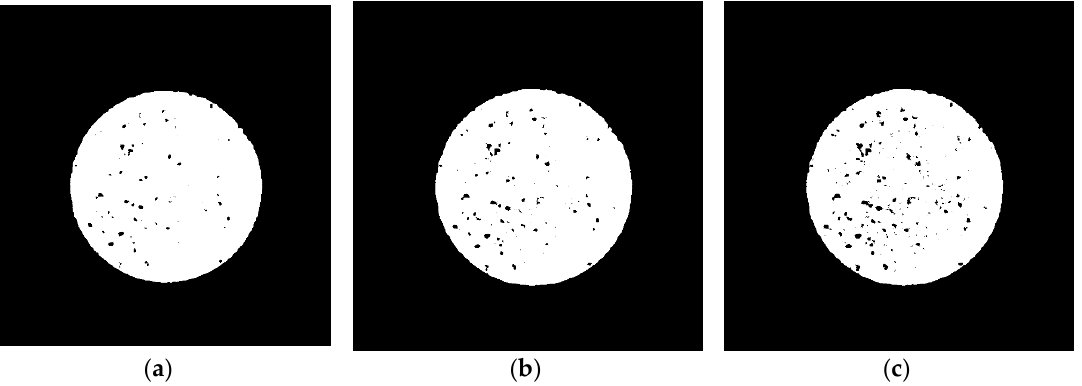
Figure 9. Threshold cutting and binarization: ( a ) threshold setting of 0–175; ( b ) threshold setting of 0–181; ( c ) threshold setting of 0–186.